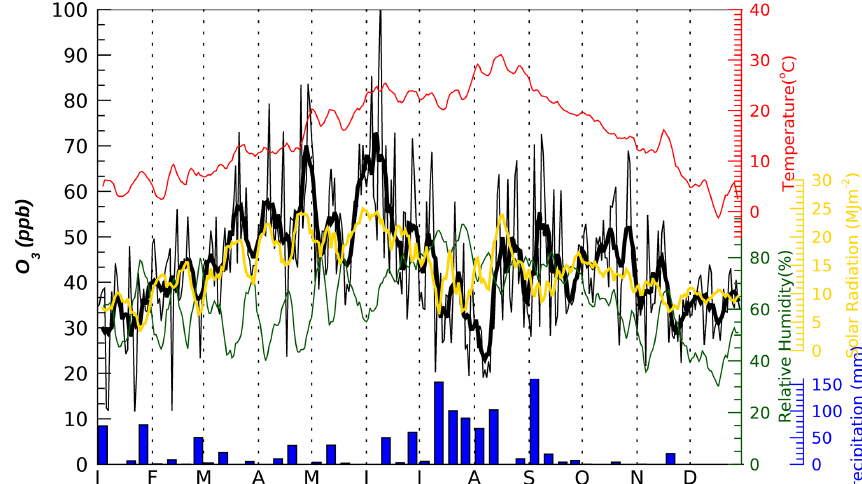
Figure 2. Daily ground-level ozone concentrations (black) with weekly moving averages applied (thick line) or not (thin line) at Pohang in 2020. The corresponding meteorological factors are overplotted: surface air temperature (red, ◦ C), solar radiation (yellow, MJm − 2 ), and relative humidity (dark green, %). The bar graph shows the total precipitation (mm) for each